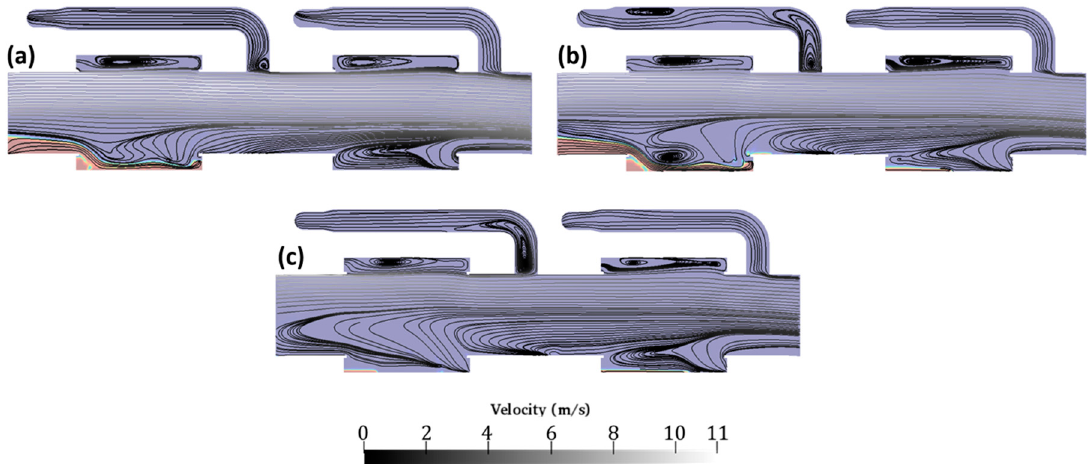
Figure 11. RANS-based instantaneous velocity streamlines around the separator units for cases ( a ) case 3 (i.e. U G = 6.4 m/s and U L = 1.34 m/s), ( b ) case 6 (i.e. U G = 4.79 m/s and U L = 1.16 m/s), and ( c ) case 9 (i.e. U G = 2.72 m/s and U L = 0.48 m/s) for the second design. The background indicates the liquid (red) and gas (blue). The contour line maps locations flow separation.